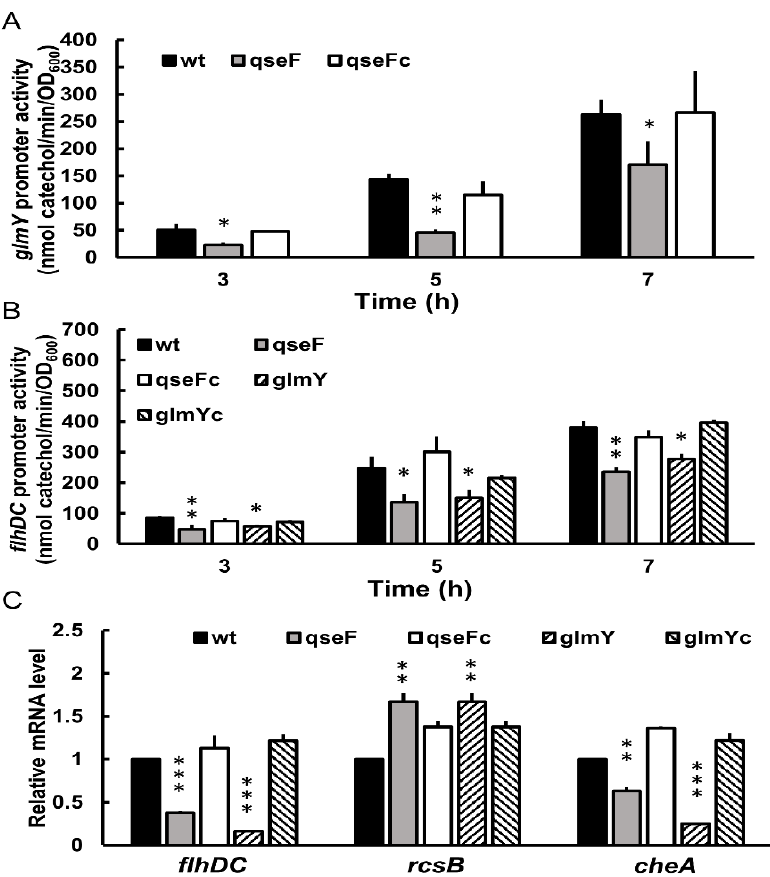
Figure 3. QseF-controlled GlmY regulated expression of flhDC , rcsB and cheA . ( A ) The glmY promoter activity in the wild-type, qseF mutant and qseF -complemented strain. ( B ) The flhDC promoter activity in the wild-type, mutants of qseF and glmY and the complemented strains. ( C ) The mRNA level of flhDC , rcsB and cheA in the wild-type, mutants of qseF and glmY and the complemented strains. In ( A , B ), bacteria cultures were spread on LB agar plate and XylE promoter activities were determined as described in Materials and Methods after incubation for 3, 5 and 7 h at 37 °C. In ( C ), the mRNA amount was measured at 5 h after inoculation on the LB agar plate. The value for the wild-type was set at 1, and other data are presented relative to this value. The data are the averages and standard deviations of three independent experiments. Significant difference from the wild-type is indicated (* p < 0.05; ** p < 0.01; *** p < 0.001 by the Student’s t test). wt, wild-type; qseF, qseF mutant; glmY, glmY mutant; qseFc, qseF- complemented strain; glmYc, glmY -complemented strain.